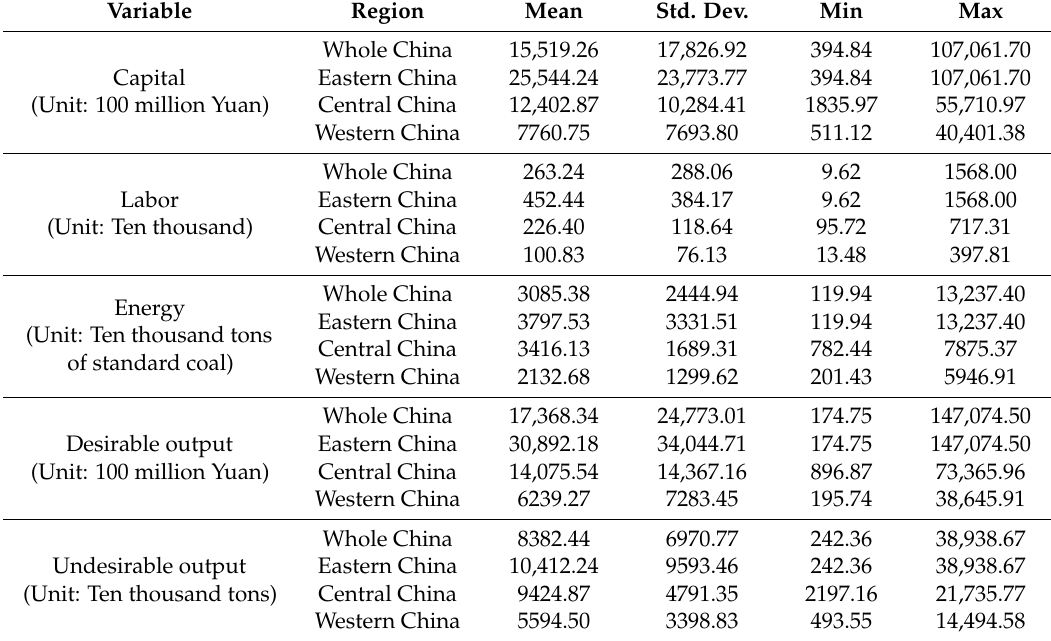
Table 1. Descriptive statistics of input and output variables in China’s industrial sector.